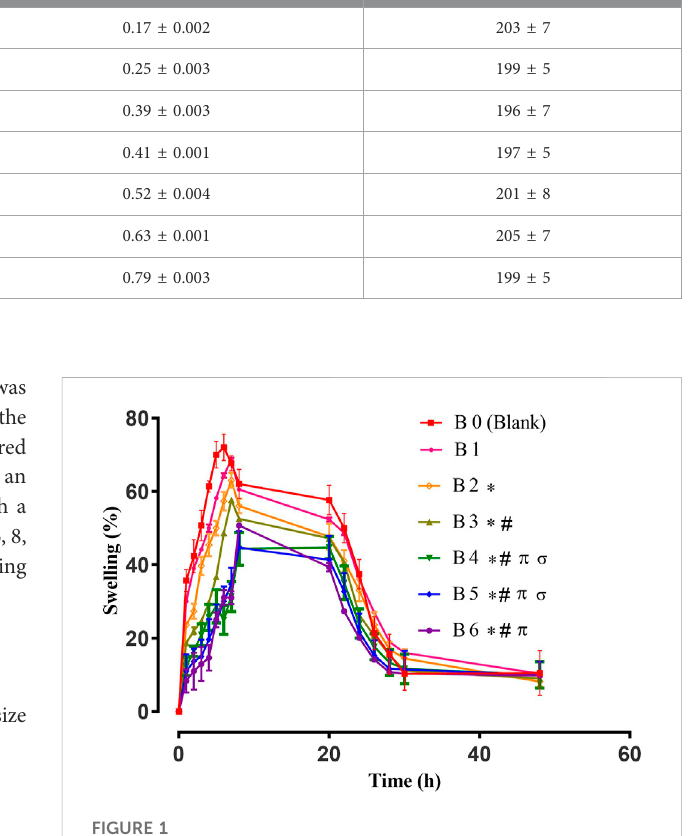
FIGURE 1 Swelling study of Hydrogel fi lms. Error bar indicates the standard deviation (n = 3, p -value < 0.05 for the highest swelling achieved by the formulations, * compared with B0 (Blank), # compared with B1, π compared with B2, σ compared with